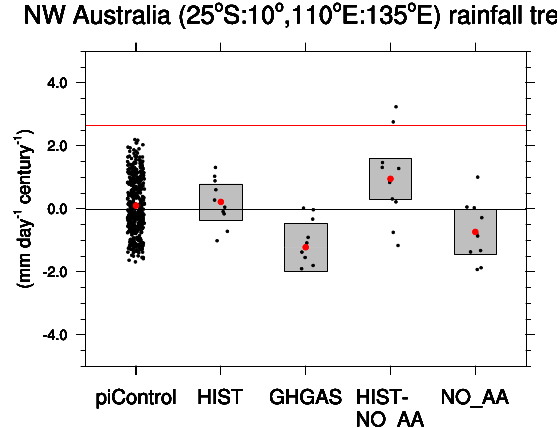
Fig. 14. 60-yr DJFM rainfall trends, averaged over land in the region 10 ◦ S to 25 ◦ S, 110 ◦ E to 135 ◦ E (shown in Fig. 1). The horizon- tal red line shows the observed 1951–2010 trend from AWAP. The small black dots show individual 1951–2010 trends from the 10- member forced ensembles (HIST, GHGAS and NO AA) and 440 60-yr trends from the 500-yr preindustrial control run (piControl). For the case of HIST minus NO AA, the 10 small black dots repre- sent trends formed by pairing run n of HIST with run n of NO AA. The large red dots show the ensemble-mean trend from each experi- ment, and the grey bars show the 95% confidence interval, based on a one-sample t-test for HIST, GHGAS and NO AA, and two-sample t-test for HIST minus NO